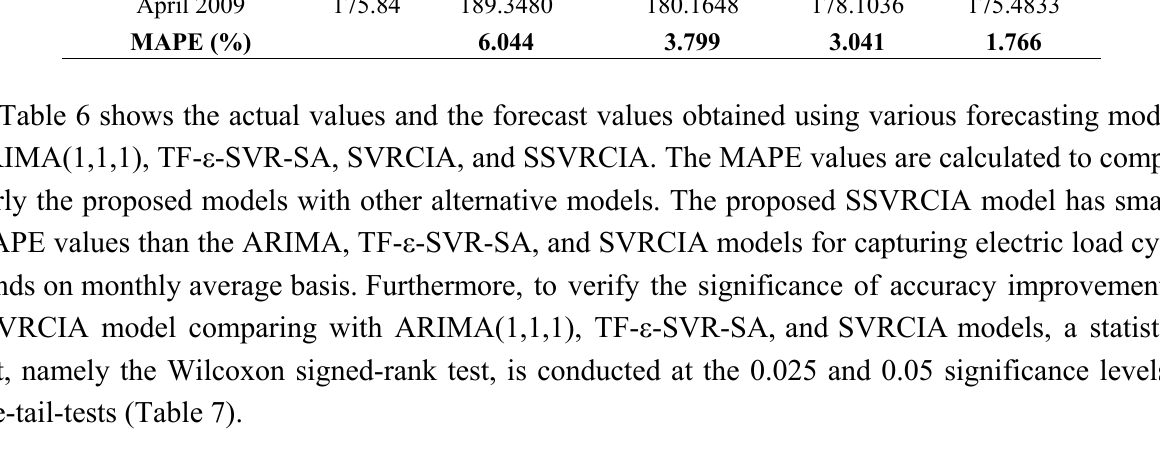
Table 7. Wilcoxon signed-rank